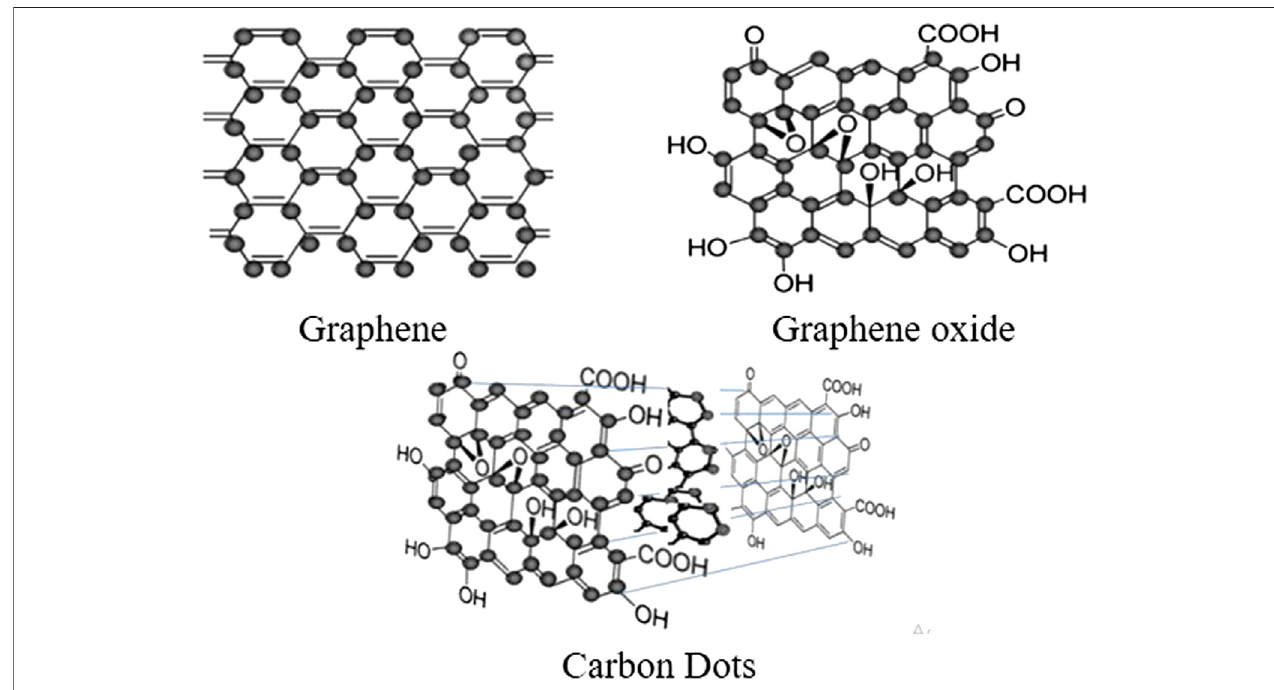
FIGURE 2 | Chemical structures of C-Dots comprise of graphene and graphene oxide structure of nanoscale carbon materials (Demchenko and Dekaliuk, 2013).